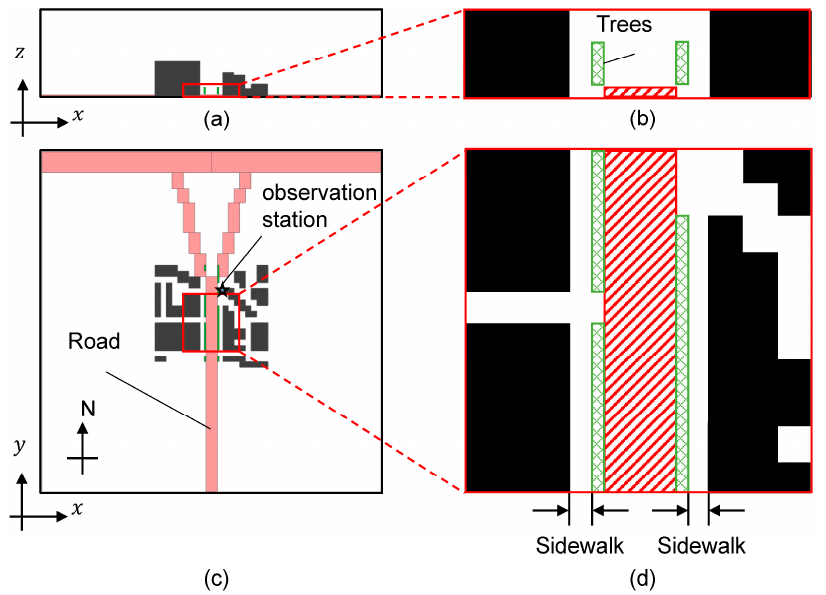
Figure 1. The lateral ( a , b ) and top ( c , d ) views of the calculation ( a , c ) and analysis ( b , d ) domains. The black, crosshatched and diagonal stripe rectangles indicate the buildings, roads and trees, respectively. Star indicates the observation station (Umeda-Shinmichi).